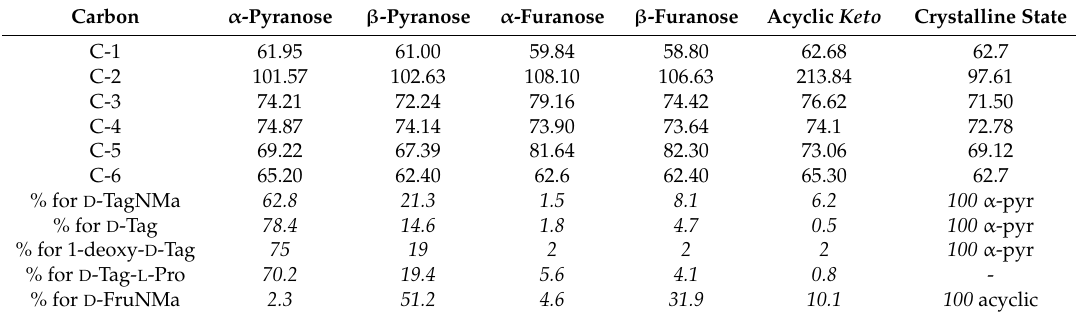
Table 1. Tentative assignments of chemical shifts (ppm) in 13 C-NMR spectra and percentage of D -tagatose- N -methylaniline ( D -TagNMa) tautomers in 1:1 pyridine/D 2 O and in solid state at 25 °C. For comparison, the tautomeric compositions of D -tagatose [8,16], 1-deoxy- D -tagatose [17,18], D -tagatose- L -proline [8], and D -fructose- N -methylaniline ( D -FruNMa) [13] are given.